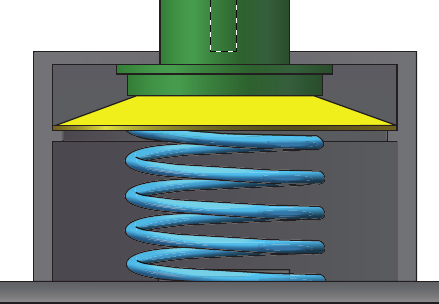
Figure 1: Prototype model of the proposed QZS isolator.